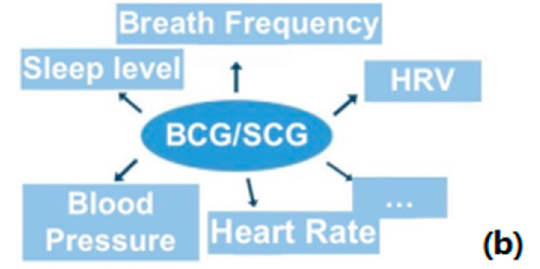
Figure 9. The types of data under the concern.